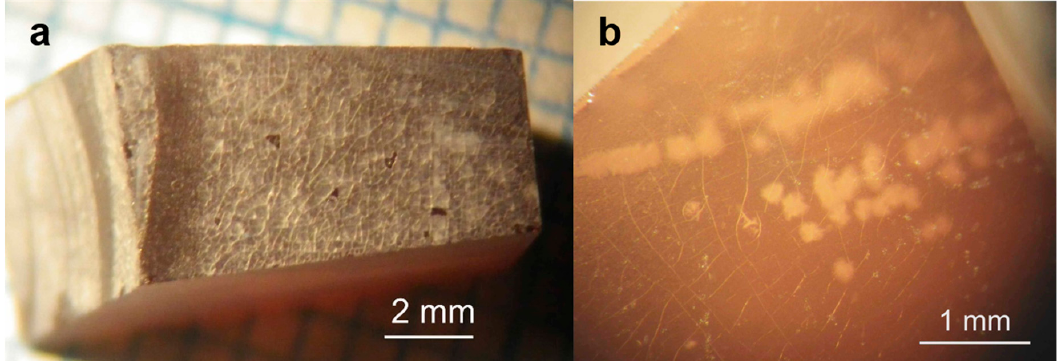
Figure 7. Sample of Na ‐ Al ‐ P glass after irradiation with gamma rays of 60 Co to cumulative dose of 6.2 × 10 7 Gy: ( a )—general image; ( b )—local area of the surface at higher magnification.